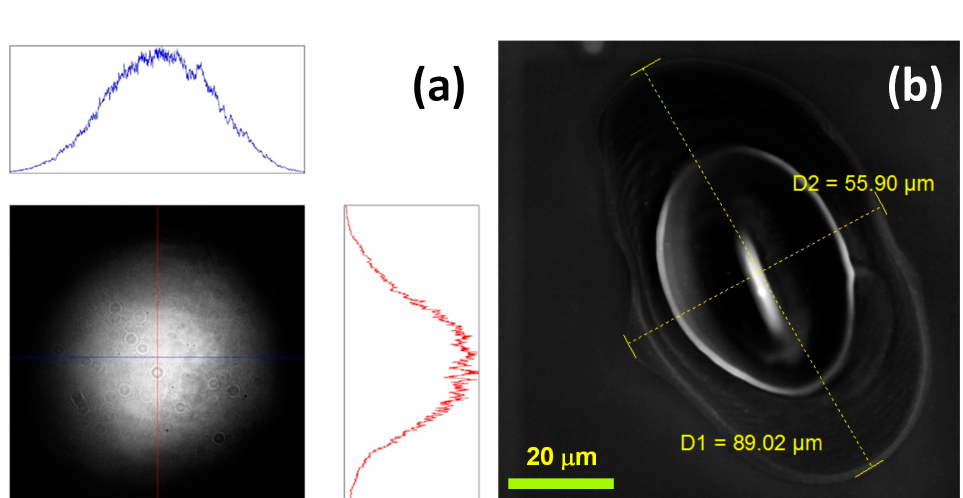
Figure 2 . ( a ) Camera captured Gaussian beam profile with plots representing Gaussian distribution profiles along the horizontal and vertical axes ( b ) SEM micrograph of elliptical spot area modified with a single 38 fs pulse of fluence 5 J/cm 2 .